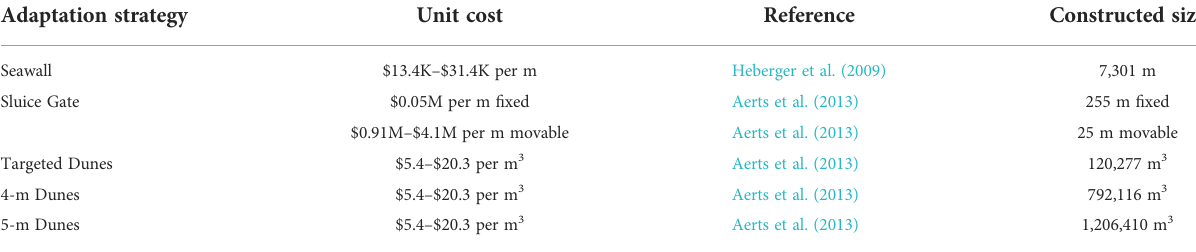
TABLE 1 Unit cost ranges (in 2021 dollars) and constructed size estimates for adaptation